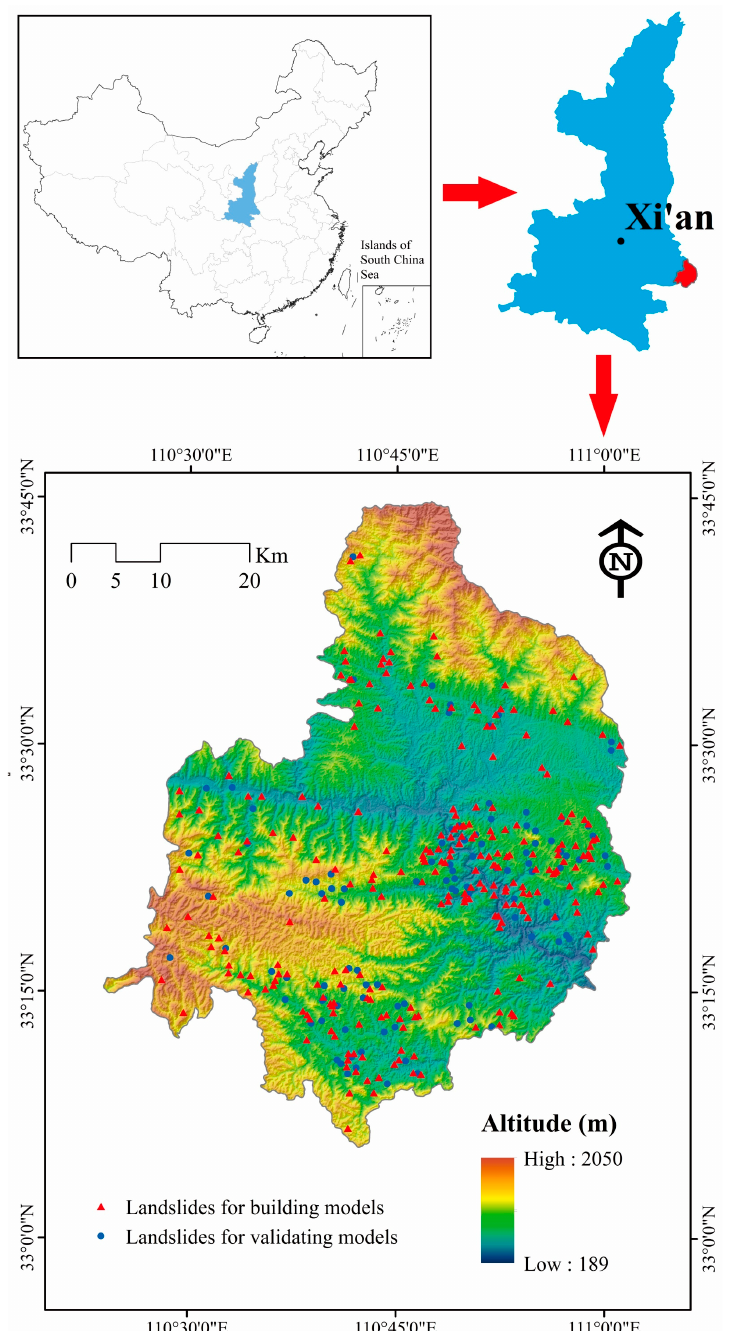
Figure 1. Location of the study area and landslide inventory.